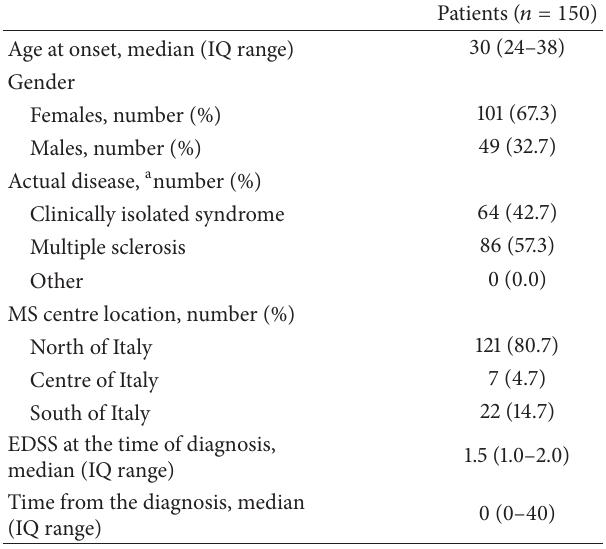
Table 1: Patients’ sociodemographic and disease-related character-